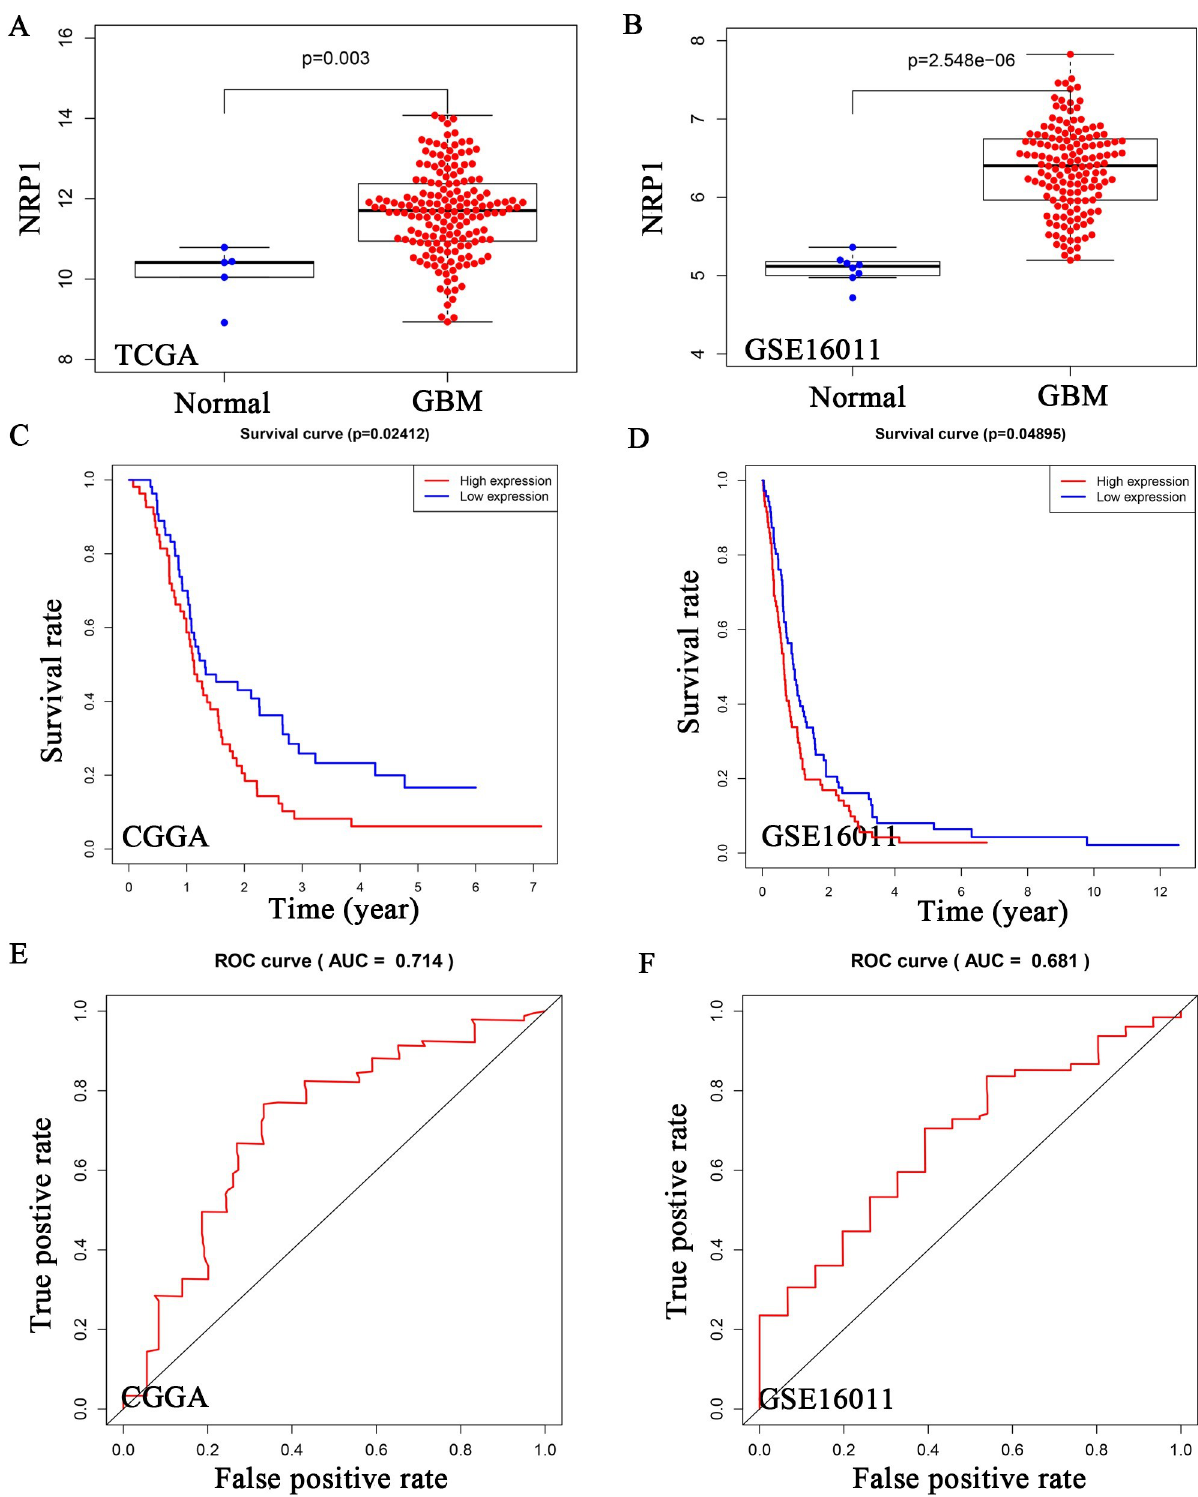
Fig 6. NRP1 expression in gliomas and the relationship with prognosis. (a, b) TCGA and GSE16011 databases were used to show NRP1 expression in non-tumor brain tissues and GBM samples. (c-f) Kaplan–Meyer analysis (c, e) and ROC analysis (d, f) were performed in TCGA and GSE16011